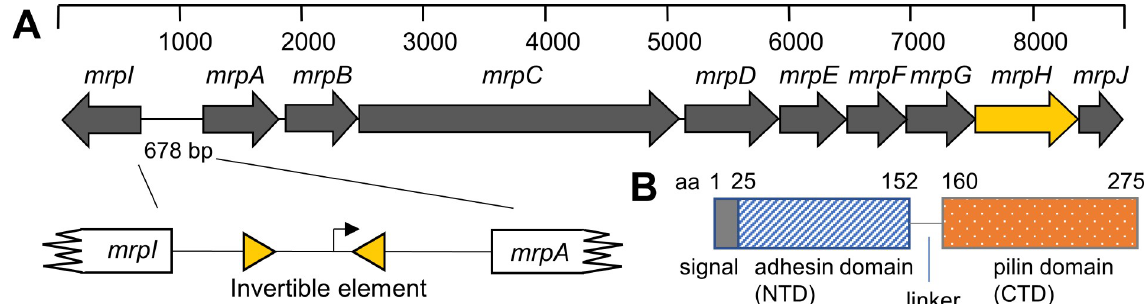
Fig 1. MR/P operon and MrpH domain organization. (A) The genes encoding MR/P fimbriae are organized as an operon. An invertible element (IE) in the mrp promoter controls mrp expression (inset), and MrpI is the recombinase that flips the IE. Therefore, mrpI mutants are either locked “ON” or “OFF” for MR/P fimbriae. The tip-located TDA is encoded by mrpH (yellow). (B) Depiction of linear MrpH. The predicted N-terminal domain (NTD) was used for protein crystallization. Because the C-terminal domain (CTD) has not yet been crystallized, the beginning residue shown here is an